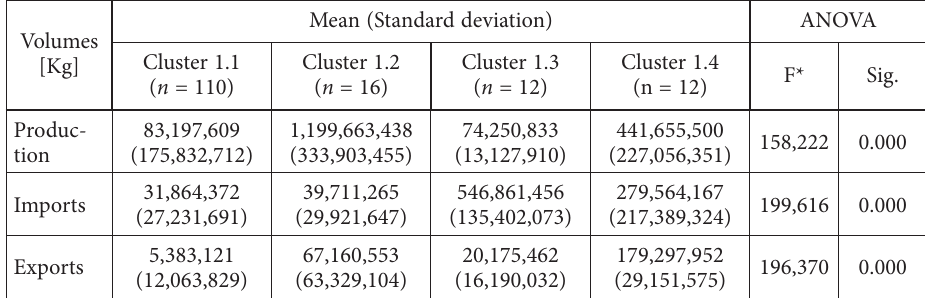
Table 5. Cluster centres and ANOVA for two-stage analysis at the second pre-crisis clustering level (source: own elaboration based on COMTRADE,